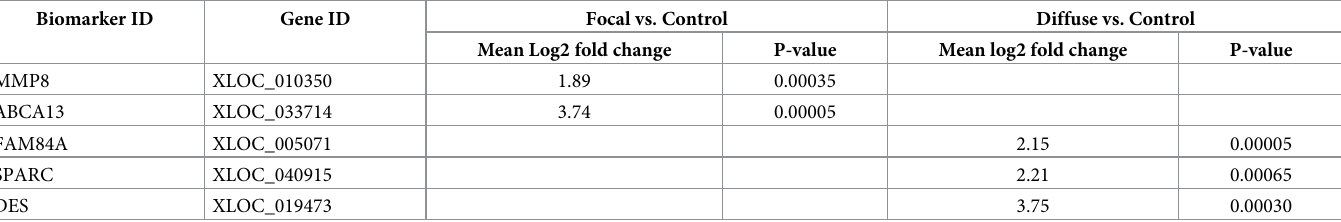
The mean Log2 fold change, is a measurement (ratio) of differential gene expression between two compared groups expressed as a logarithm; MMP8, bovine matrix metallopeptidase 8; ABCA13, bovine ATP binding cassette subfamily A member 13; FAM84A, bovine family with sequence similarity 84 member A; SPARC, bovine secreted protein acidic and cysteine rich; DES. bovine